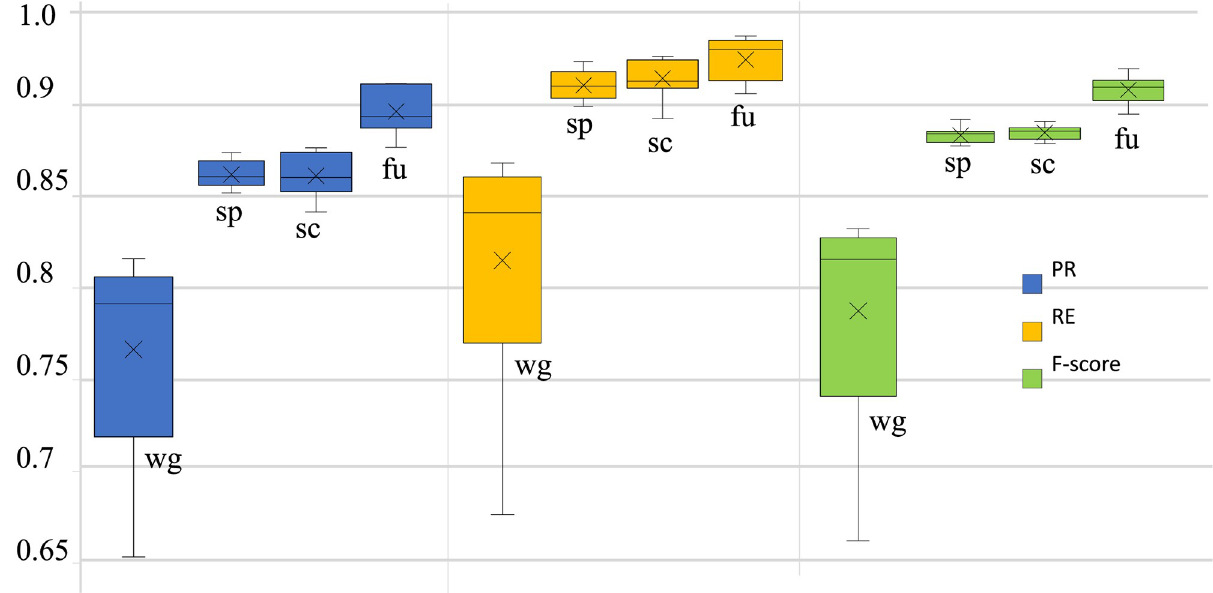
Fig 9. IQR plots of PR, RE, and F1 for apnea detection obtained across all folds. The center line indicates the median, the box limits indicate the upper and lower quartiles, the whiskers indicate 1.5 × IQR, and × indicates the mean. The images are Wigner–Ville distribution images (wg), scalogram images (sc), spectrogram images (sp), or fused images (fu).